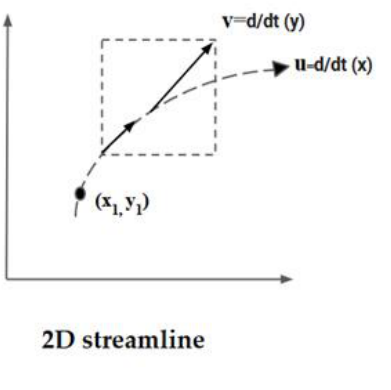
Figure 4. Streamline calculation in both 2-D and 3-D cases.